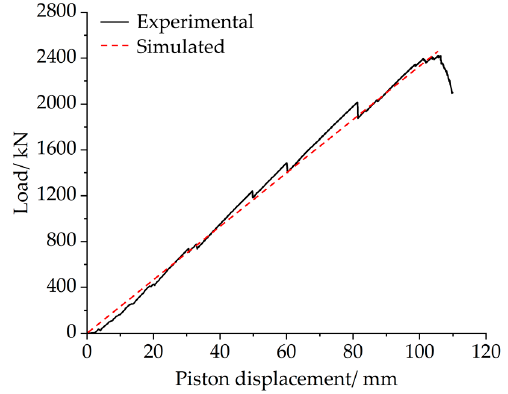
Figure 13. Load–displacement curve of the cable.